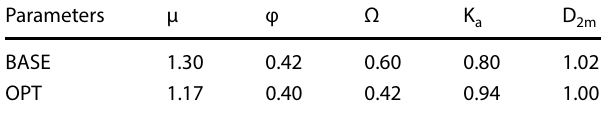
Table 4 1D parameters on the target turbine